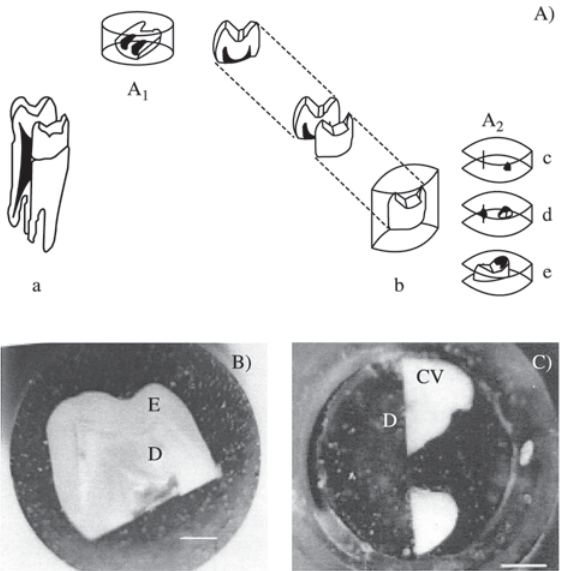
samples for hardness measurements. a) Longitudinal cut; b) resin embedding; A ) longitudinal sample; A 1